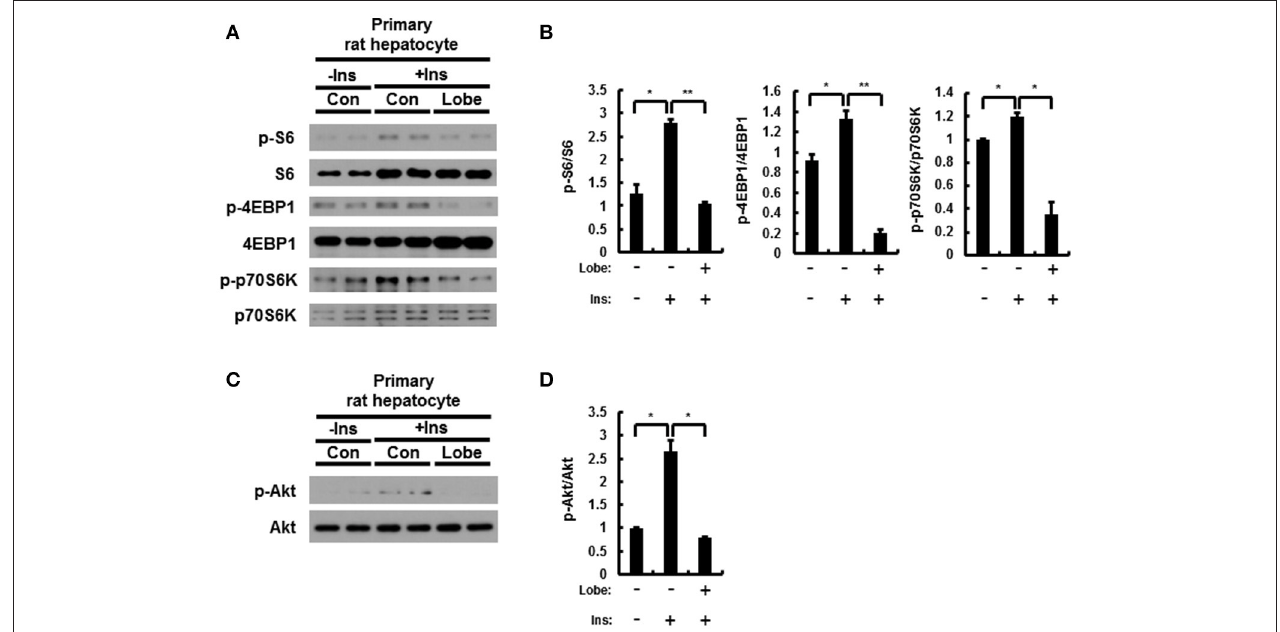
FIGURE 7 | Lobeglitazone inhibits insulin mediated stimulation of mTORC1 signaling in rat primary hepatocyte. (A–D) The isolated cells were incubated in M199 supplemented with 100nM dexamethasone and 1nM insulin overnight, and then insulin was treated to a final concentration of 100nM with or without lobeglitazone. (A,C) Primary hepatocytes isolated from rats were lysed and subjected to immunoblot anlaysis with antibodies to indicated proteins. (B,D) The intensity of protein bands in (A,C, respectively) and was determined by densitometry. Data in (B,D) are presented relative to the corresponding value for only vehicle-treated cells and are